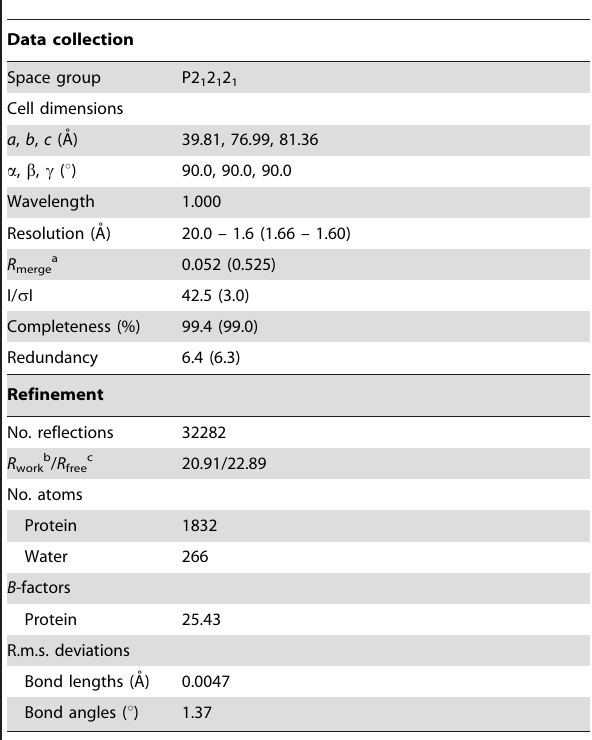
Table 1. Crystallographic data and refinement statistics.